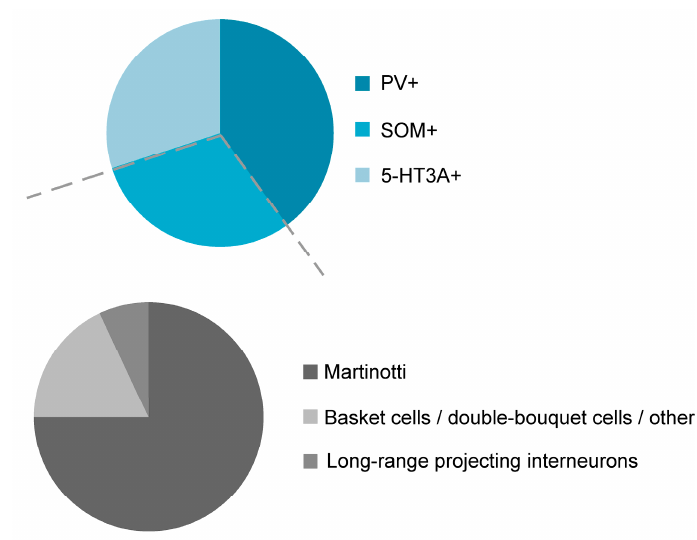
Figure 1. GABAergic interneurons are divided into three distinct and non-overlapping neurochemical classes: Parvalbumin-containing (PV + ), somatostatin-expressing (SOM + ), and 5-HT 3A -receptor-containing (5-HT 3A receptor + ) interneurons (upper panel). The class of SOM + interneurons in turn is divided into Martinotti cells and non-Martinotti cells that can be subdivided into long-range projecting interneurons and, among others, basket cells and double-bouquet cells (lower panel).